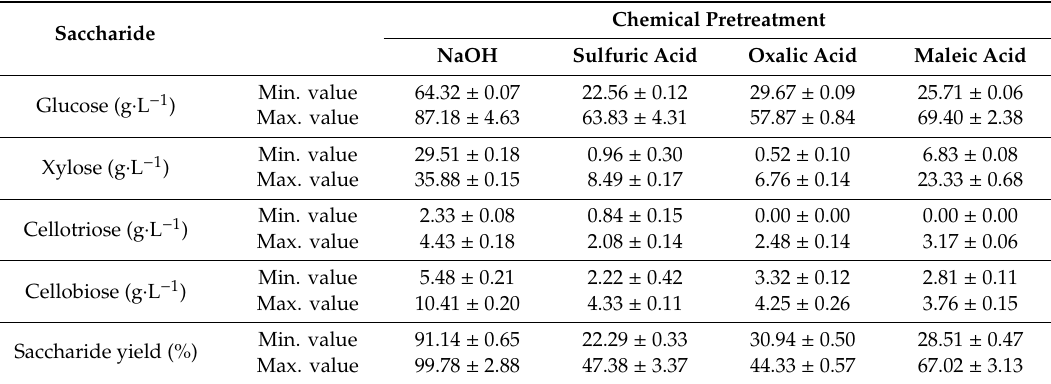
Table 2. Summary of the saccharide composition of SCB hydrolysate as a function of the di ff erent chemical